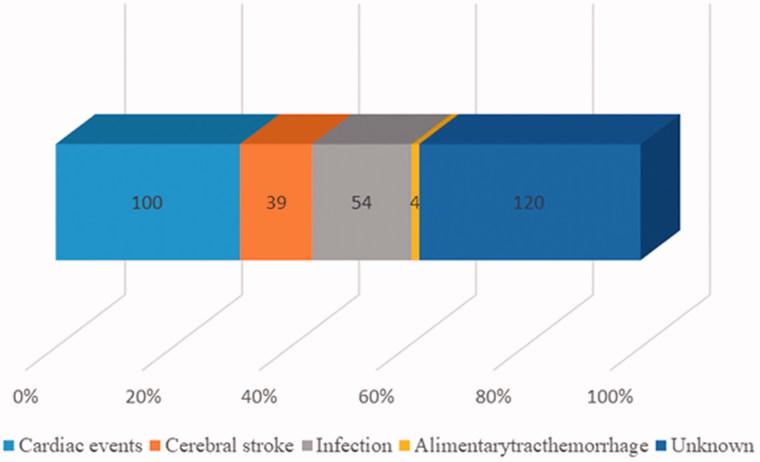
The causes of death. X-axis stood for the distribution of percentages, and the digital in the graph stood for the number of different causes. Different color stood for different causes of death. The percentage of cardiac events, cerebral stroke, infection, alimentarytracthemorrhage and unknown were 30.30, 11.82, 16.36, 1.21 and 36.36%.